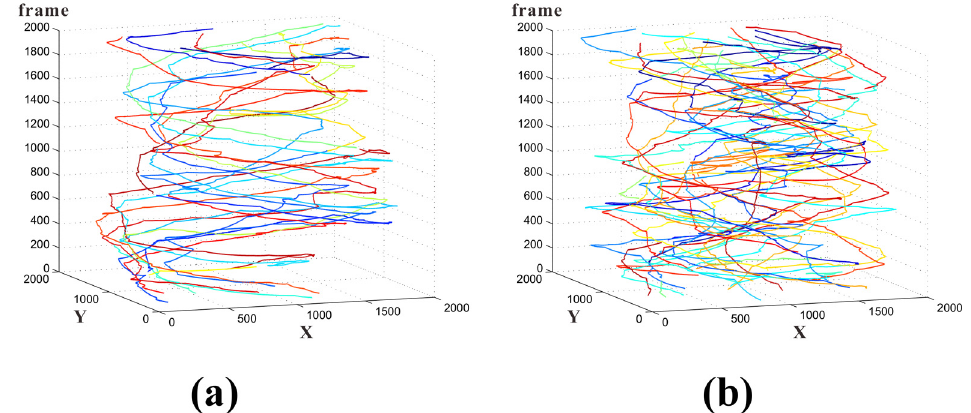
Fig 7. Tracking results. Z-axis represents the frame number, X-axis and Y-axis are coordinates of the image plane. Different colors indicate different individuals. (a). Tracking results of 10 fish for 2000 frames; (b). Tracking results of 20 fish for 2000